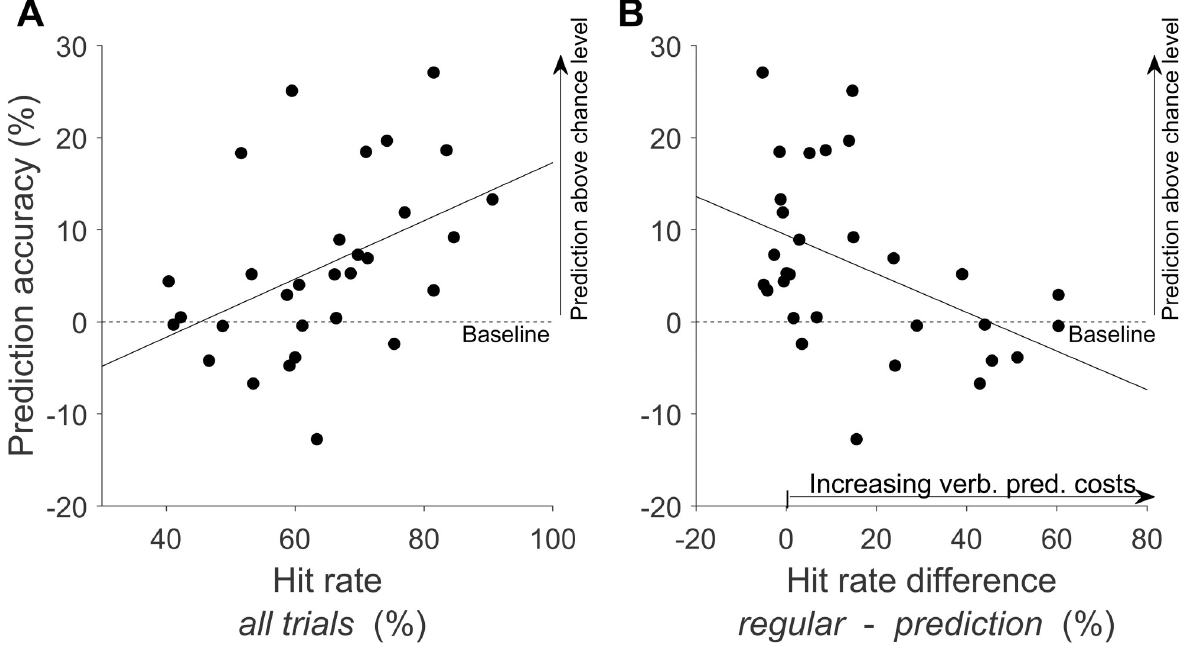
Fig 3. Correlations of throwing performance with prediction accuracy relative to individual chance level (see 2.6 “Analysis of verbal responses”). Each dot represents the average values of a single participant relative to individual chance level (represented by the dashed line).(A) Correlation of prediction accuracy with hit rates over all experimental trials ( prediction condition and regular condition together). (B) Correlation of prediction accuracy with the difference in hit rates between the prediction condition and the regular condition (verbal prediction costs). The larger the difference value, the lower the performance in the prediction condition (and the higher the prediction